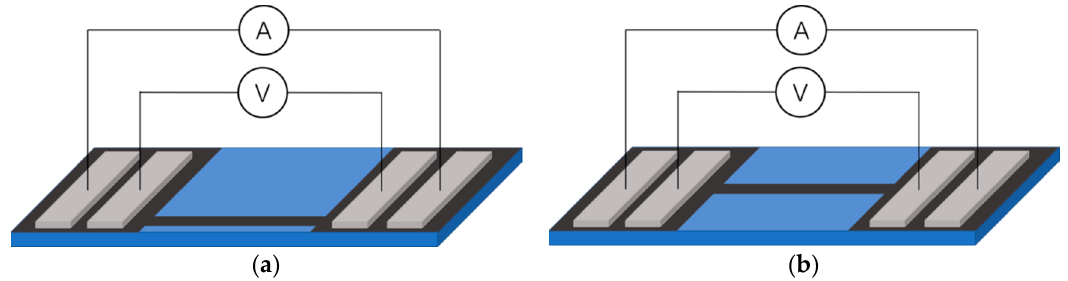
Figure 4. The schematic diagram of the four-probe method for the I c test of the GdYBCO micro-bridge: ( a ) the edge position; ( b ) the middle position.